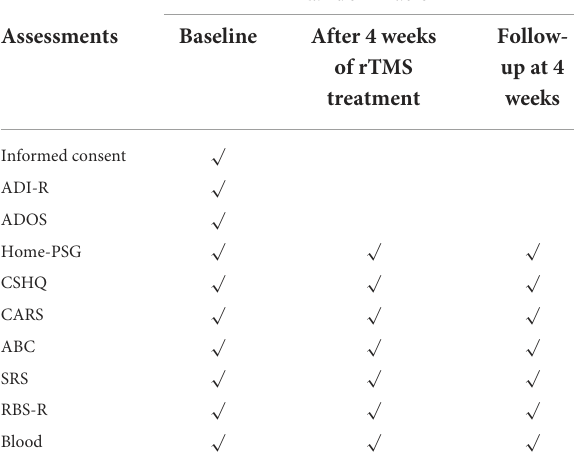
TABLE 1 Summary of the